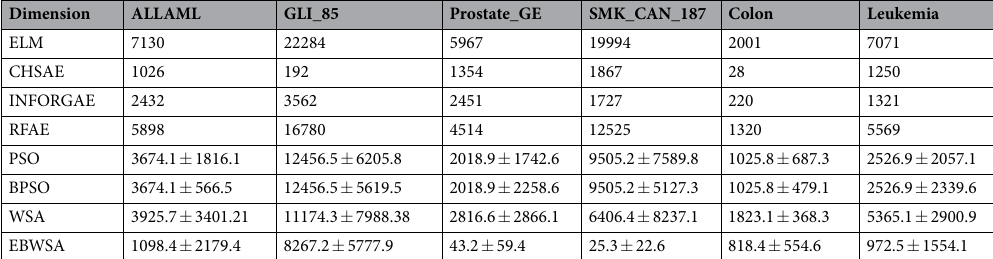
Table 2. Dimensions of all datasets with different